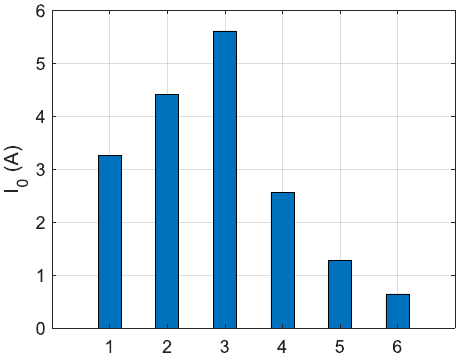
Figure 13. Zero sequence current magnitude.